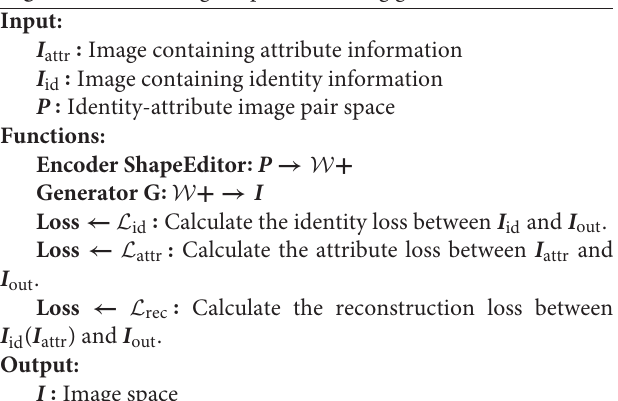
Algorithm 1 Training ShapeEditor using gradient